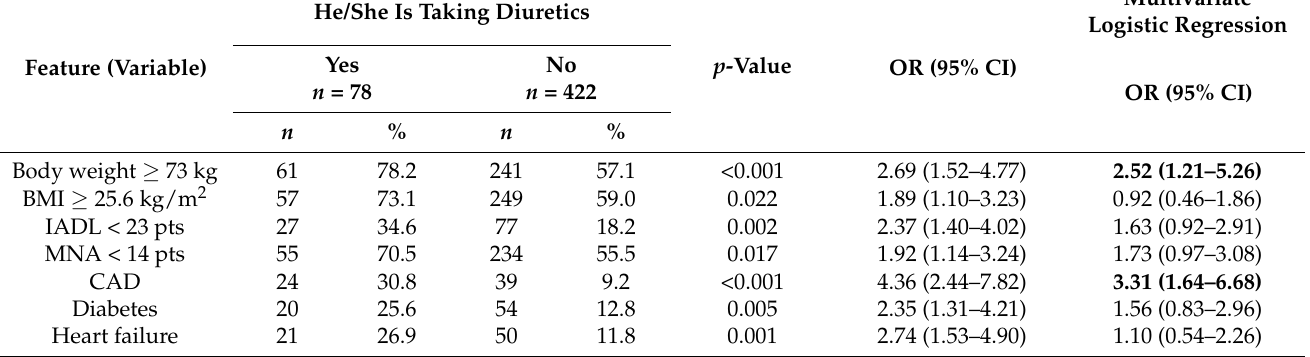
Table 6. Sociodemographic, clinical and mental characteristics in groups that differ in diuretic intake and test